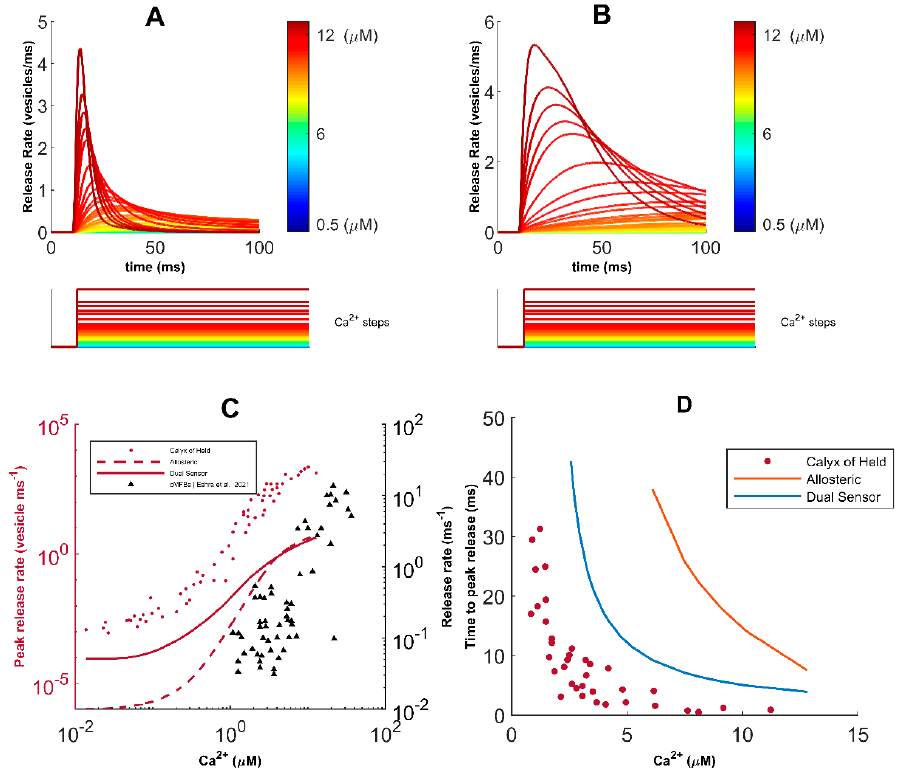
Figure 4. Characterization of neurotransmission in response to [ Ca 2 + ] steps: ( A ) Total release events cyt obtained from a single dual − sensor fusion process after clamping [ Ca 2 + ] at different values; ( B ) Re- cyt lease profile following allosteric fusion in response to stepwise [ Ca 2 + ] clamp; ( C ) Regulation of the cyt peak release rate in response to clamped [ Ca 2 + ] levels shows lower and right-shifted dose responses cyt relative to the experimental data for the Calyx of Held; ( D ) [ Ca 2 + ] dependence of time − to − peak cyt rate indicates exponentially decreasing but longer time delay to peak release when matched with data for the Calyx of Held. Experimental values shown for comparison in ( C , D ) are from